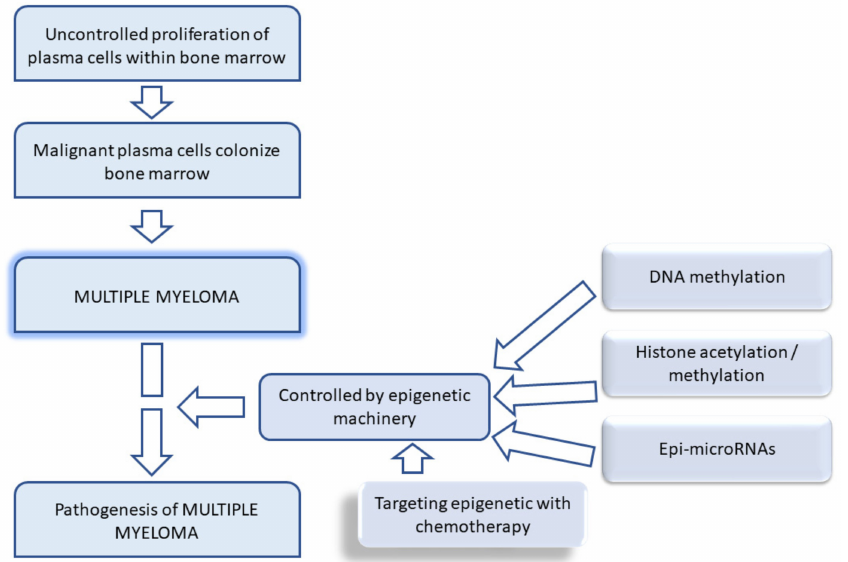
Figure 1. Schematic diagram showing etiology of multiple myeloma and the epigenetic machinery